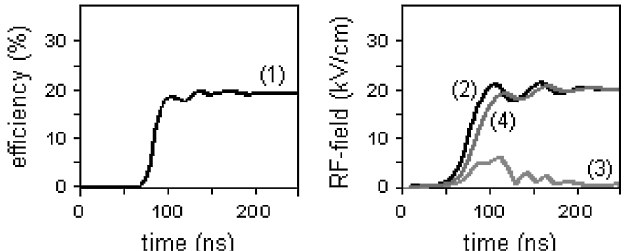
FIG. 4. Simulation of the FEM operation at a high- Q resonant load for parameters close to conditions of the JINR-IAP experi- ment with ideal matching between the load’s and the radiation frequencies. Time dependence of (1) the FEM efficiency and wave beams (2) incident, (3) reflected, and (4) passed through the